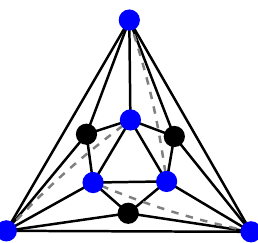
, whose period is predicted by supersymmetric localisation in Figure 5. The graph for f (5) 4